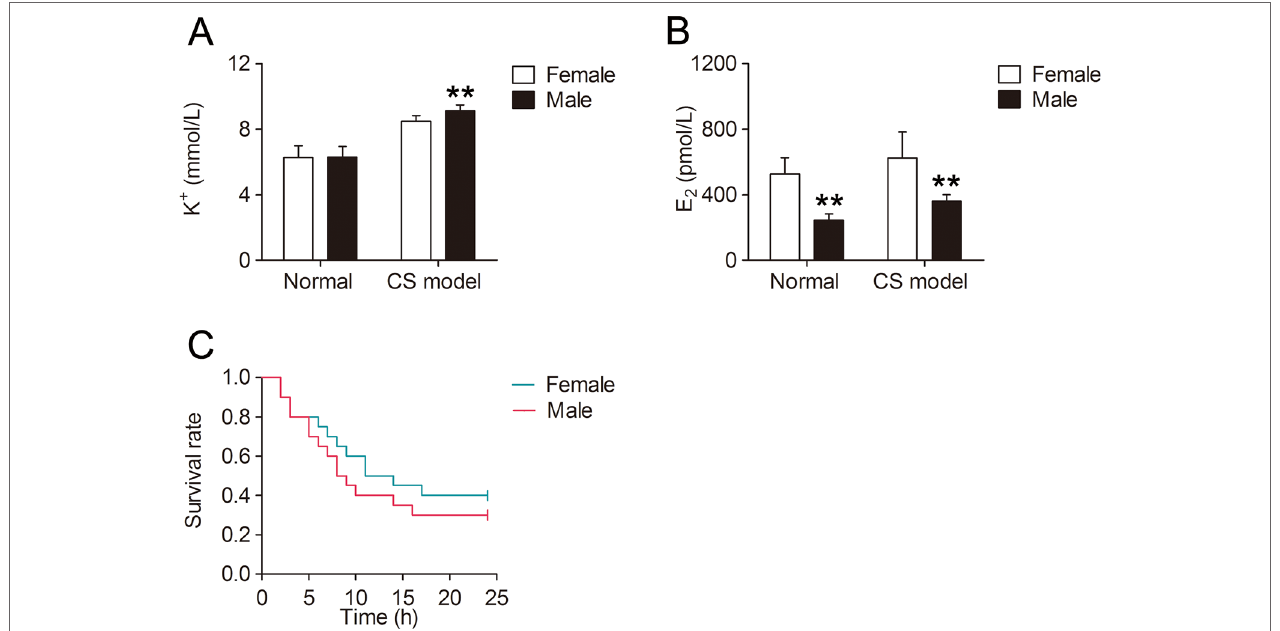
FIgURE 1 | Gender difference of serum K + , E 2 , and mortality in mice with crush syndrome (CS). Blood samples of mice with CS were collected at 6 h after decompression (n = 6 per group). Serum K + level was significantly lower in female CS models than that in male (A) . Serum E 2 level was much higher in both female and male CS models than that in normal mice (B) . There was no significant difference in survival time between female and male CS models (C, n = 20 per group). ** P < 0.01 vs. female.